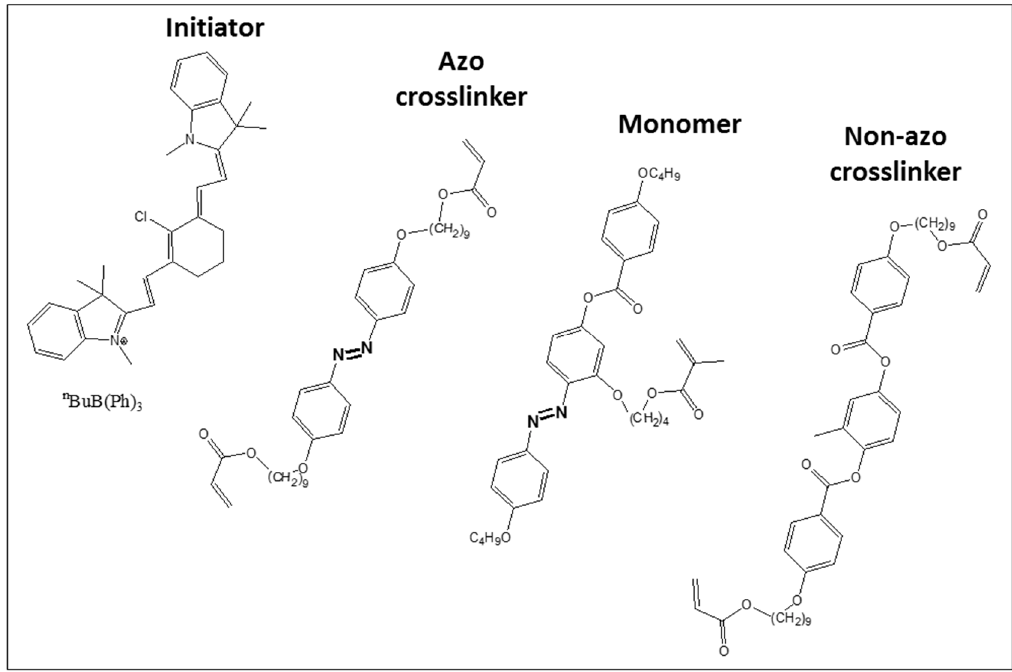
Figure 2. Chemical structures of the initiator ( λ abs = 780 nm), azo crosslinker (c 74 °C n 91 °C i), monomer (c 53 °C n 84 °C i), and the non-azo crosslinker (c 66 °C n 92 °C i). Note: c = crystalline, n = nematic, i = isotropic.